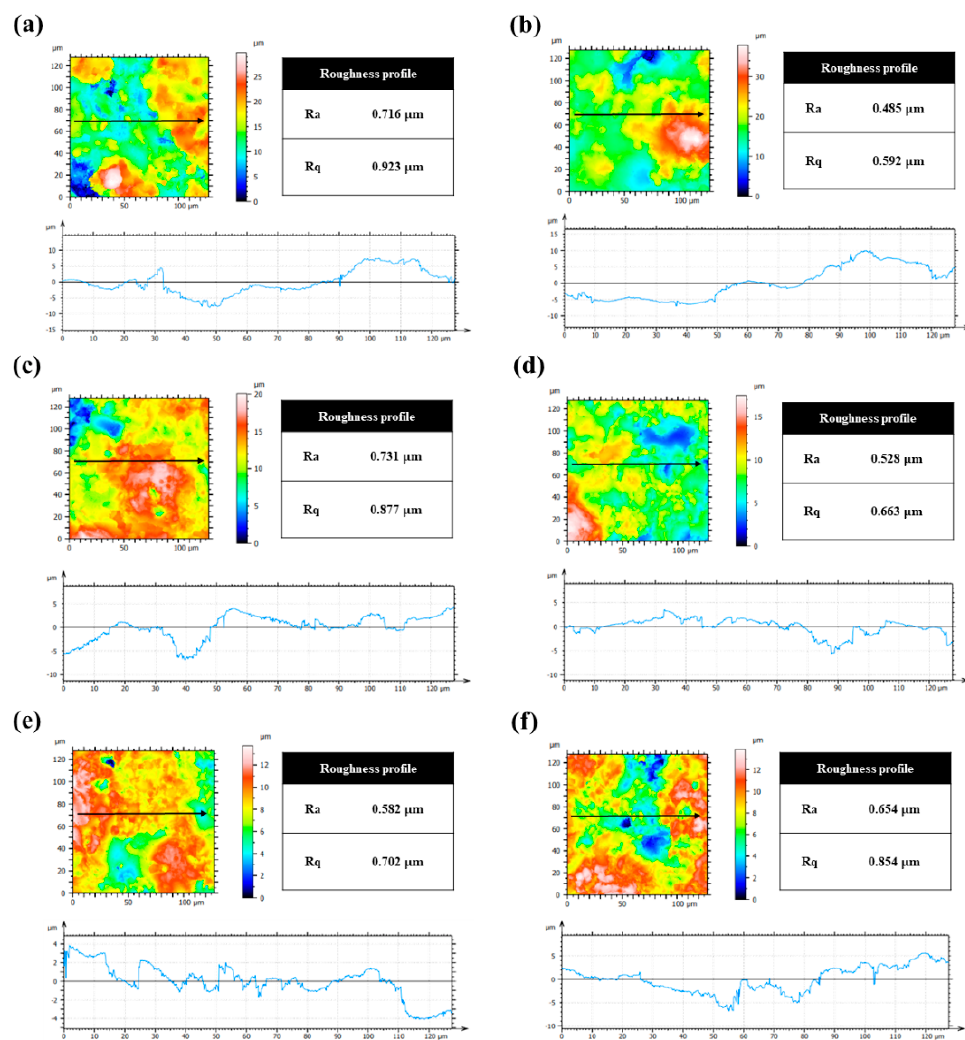
Figure 8. Confocal microscopy surface roughness of the APS–Y 2 O 3 coating: ( a ) pristine APS–Y 2 O 3 , ( b ) APS–Y 2 O 3 plasma exposure and after cleaning with piranha solutions prepared at ratios of ( c ) 2:1, ( d ) 3:1, ( e ) 4:1, and ( f ) 5:1.